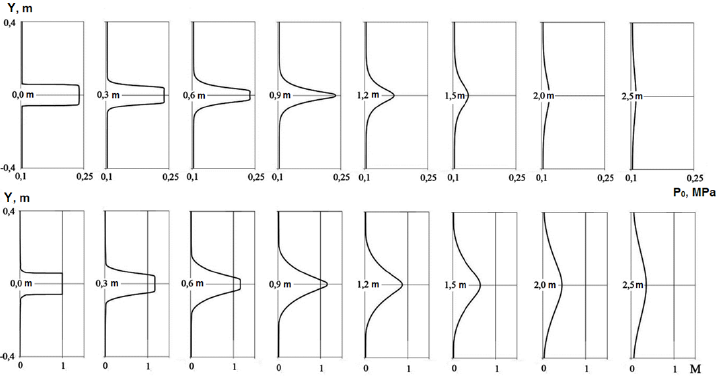
Figure 14. Distribution of the total pressure and Mach number in the cross sections over the stationary jet length for Р 02 (0) = 0.235 MPa at the nozzle cut.